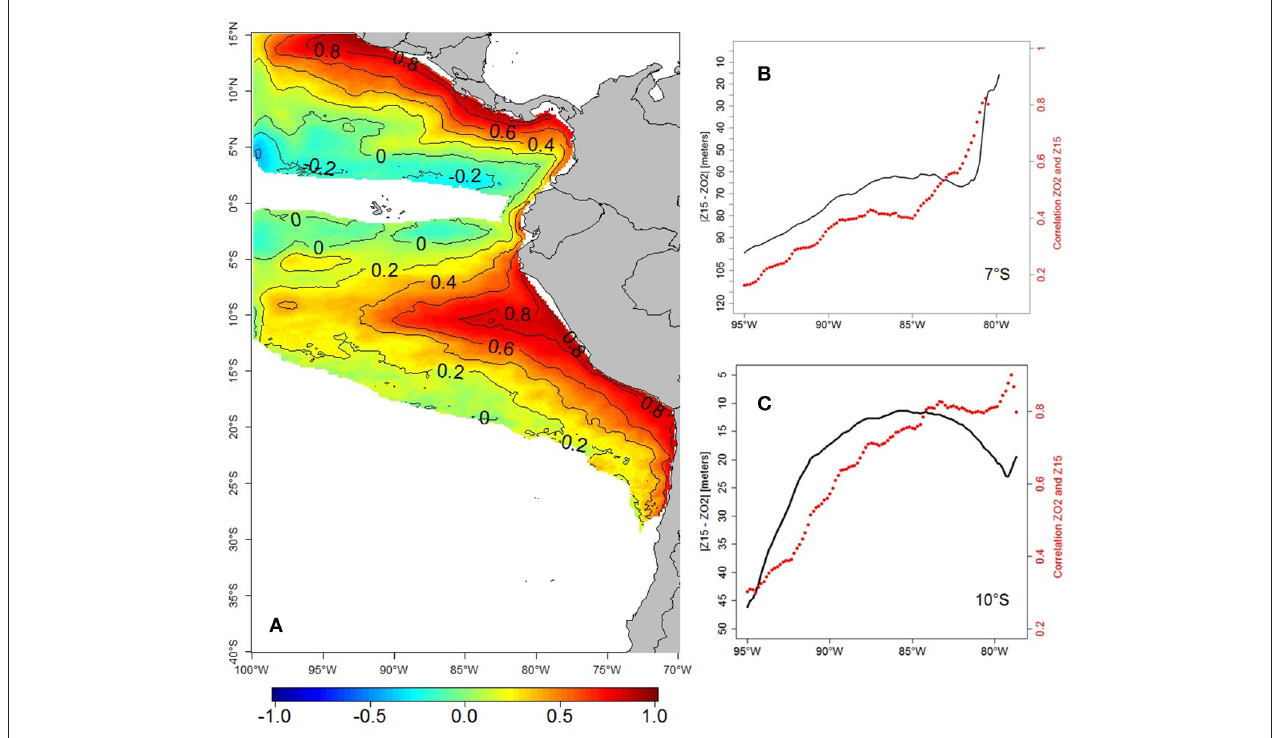
FIGURE 13 | Spatial correlation between modeled ZT15 and ZO2 monthly anomalies in the period 1958–2008 (A) . Mean absolute difference (|ZT15–ZO2|, black line, in meters) and correlation (red line) between ZO2 and Z15, from the coast to 95 ◦ W, at 7 ◦ S (B) and 10 ◦ S (C) .